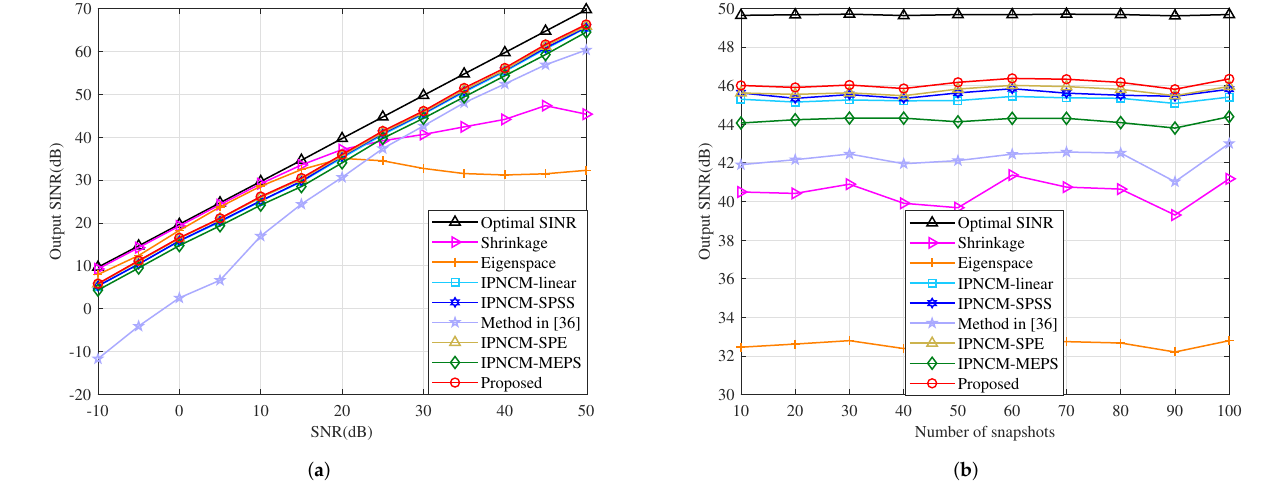
Figure 15. Output SINR in the case of SV random error versus ( a ) input SNR, JNR = 30 dB, K = 50. ( b ) the number of snapshots, SNR = 30 dB, JNR = 30